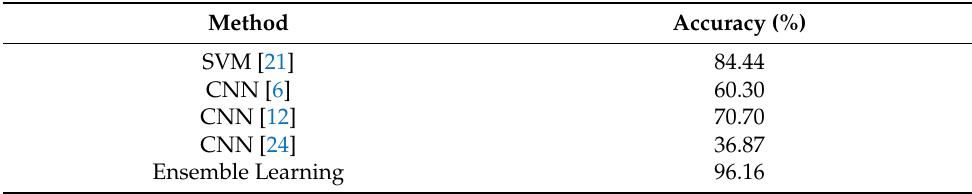
Table 14. Comparative results on TSRD